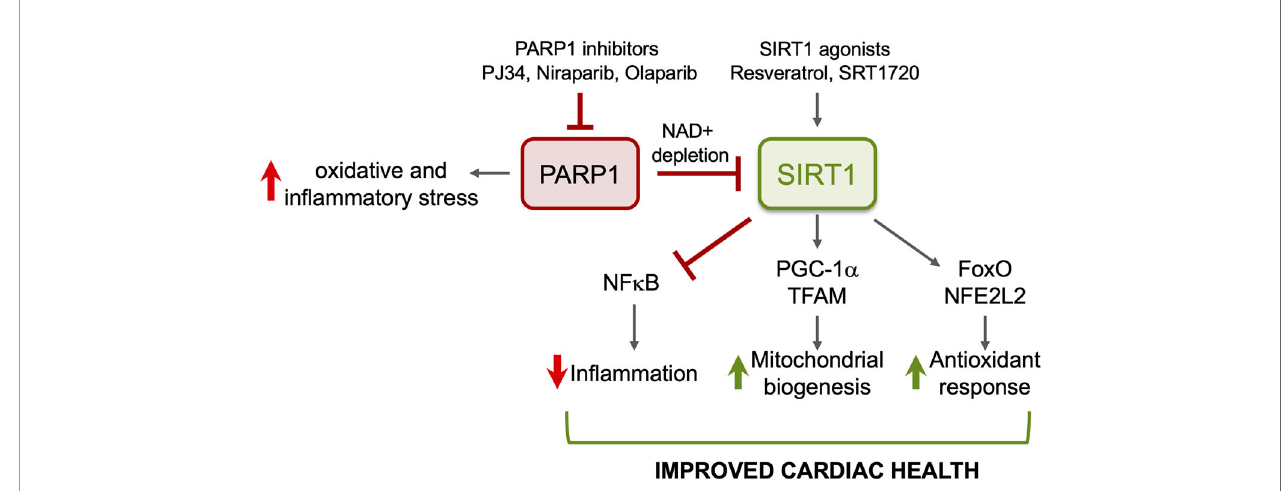
FIGURE 4 | Potential bene fi ts of SIRT1 agonists in CD. ROS induced oxidative adducts cause PARP1 hyperactivation that suppresses mitochondrial DNA replication and transcription and signals in fl ammation. PARP1 suppresses SIRT1 activity in Chagasic heart through depletion of NAD + pool. Pharmacological inhibitors of PARP1 or activators of SIRT1 will enhance SIRT1-mediated deacetylation and will have cytoprotective effects in Chagas disease through inhibition of oxidative stress and in fl ammation and induction of antioxidant response and mitochondrial